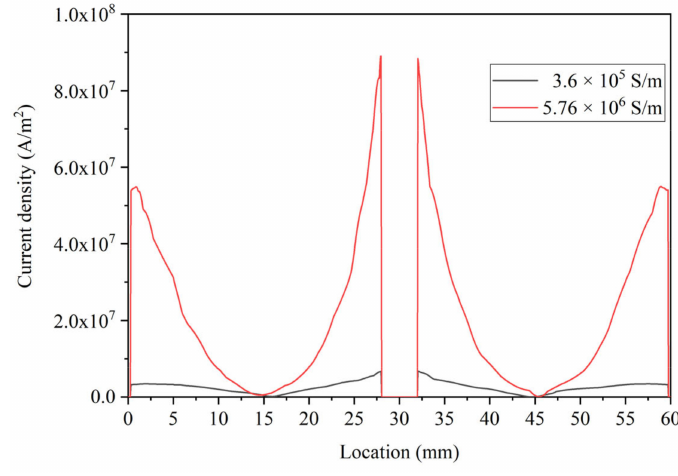
Figure 15. Current density variation under two conductivity rates.